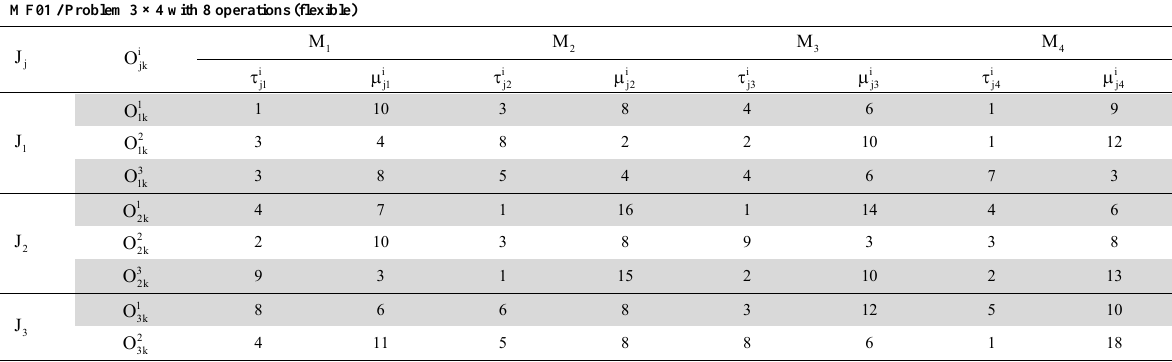
A Flexible Job-Shop Scheduling Problem MF01 / Problem 3 × 4 with 8 operations